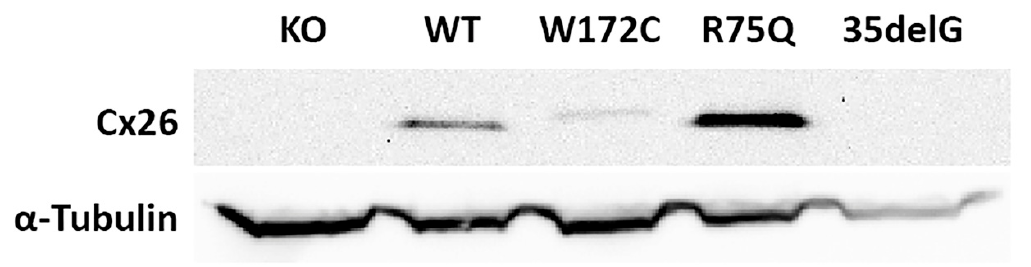
Figure 3. Analysis of the Cx26 protein expression in transgenic HeLa cell lines. The total lysates of cells were subjected to Western blot analysis with antibodies against Cx26 and the loading control, α -tubulin. The panels of Cx26 variants are designated as KO, WT, W172C, R75Q, and 35delG for cell lines HeLa Cx26-KO, HeLa-Cx26wt, HeLa-p.W172C, HeLa-p.R75Q, and HeLa-c.35delG, respectively.